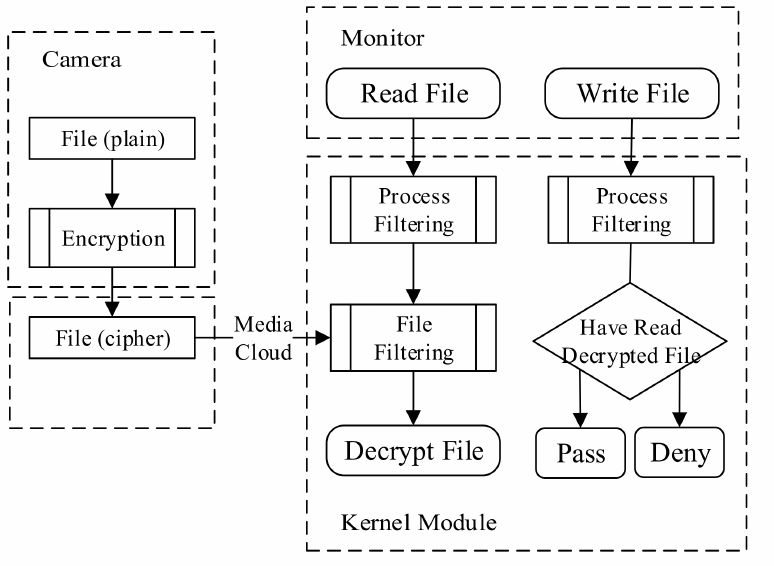
Figure 4. Encryption and decryption